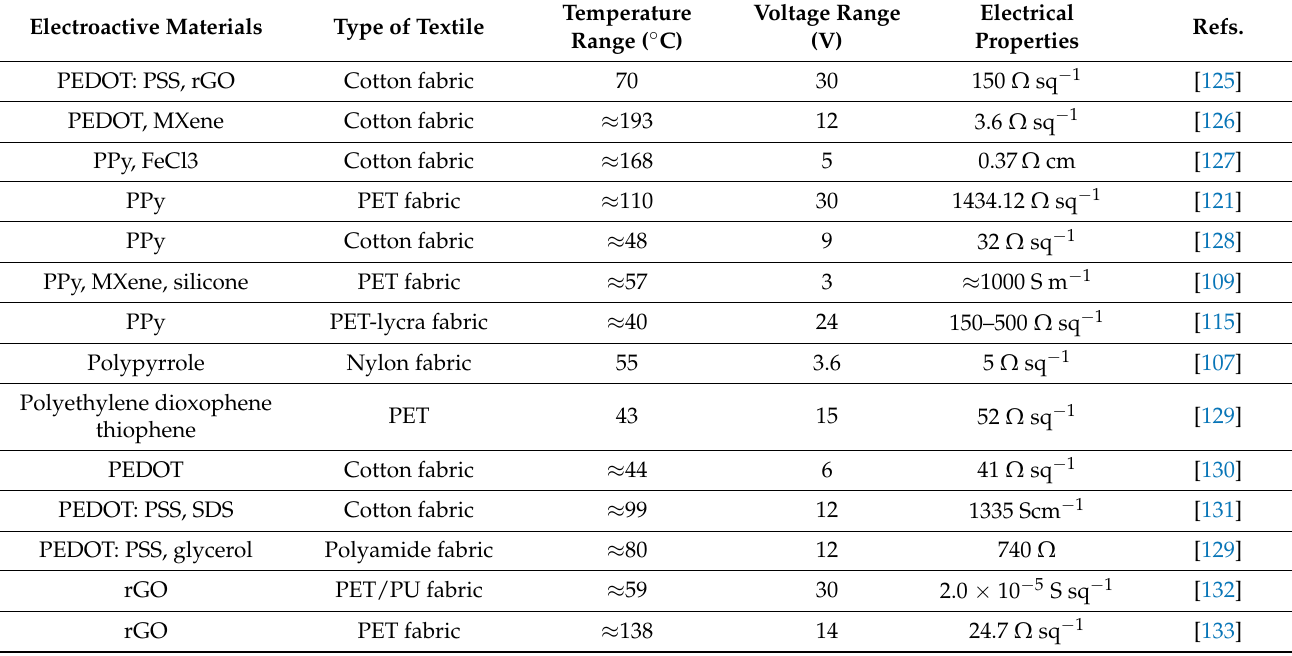
Table 4. Summary of polymer-coated heating